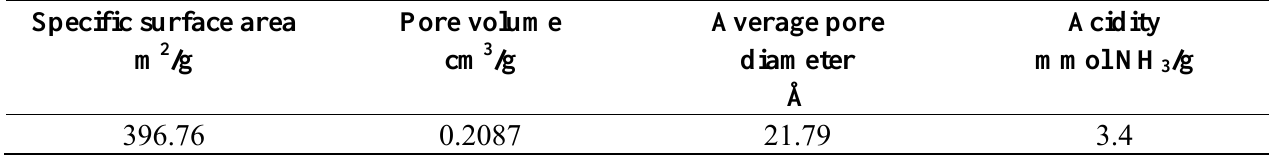
Table 1. Textural properties and acidity of β